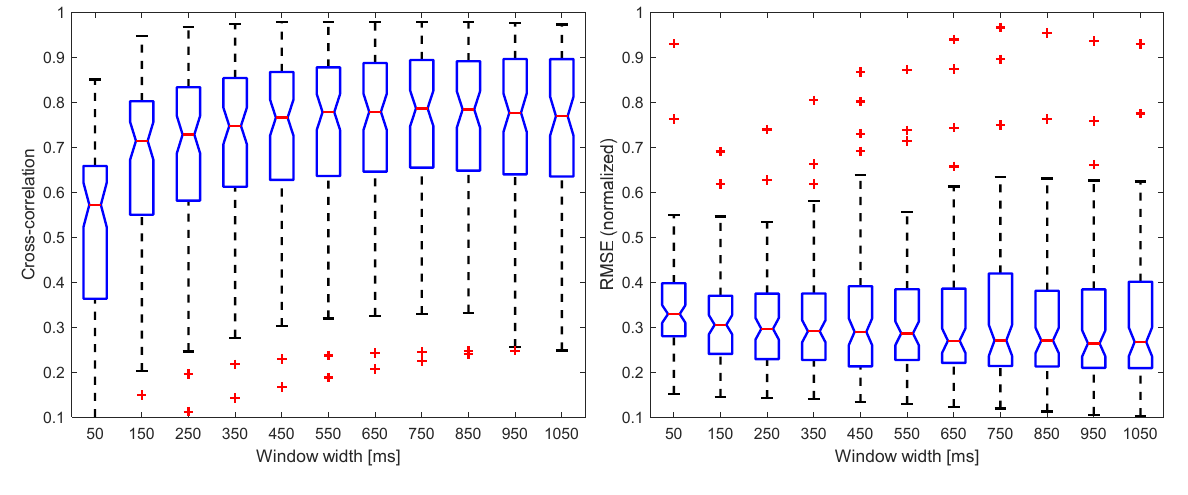
Figure A6. RMSE ( left ) and cross-correlation ( right ) of Tf algorithm for different window sizes.